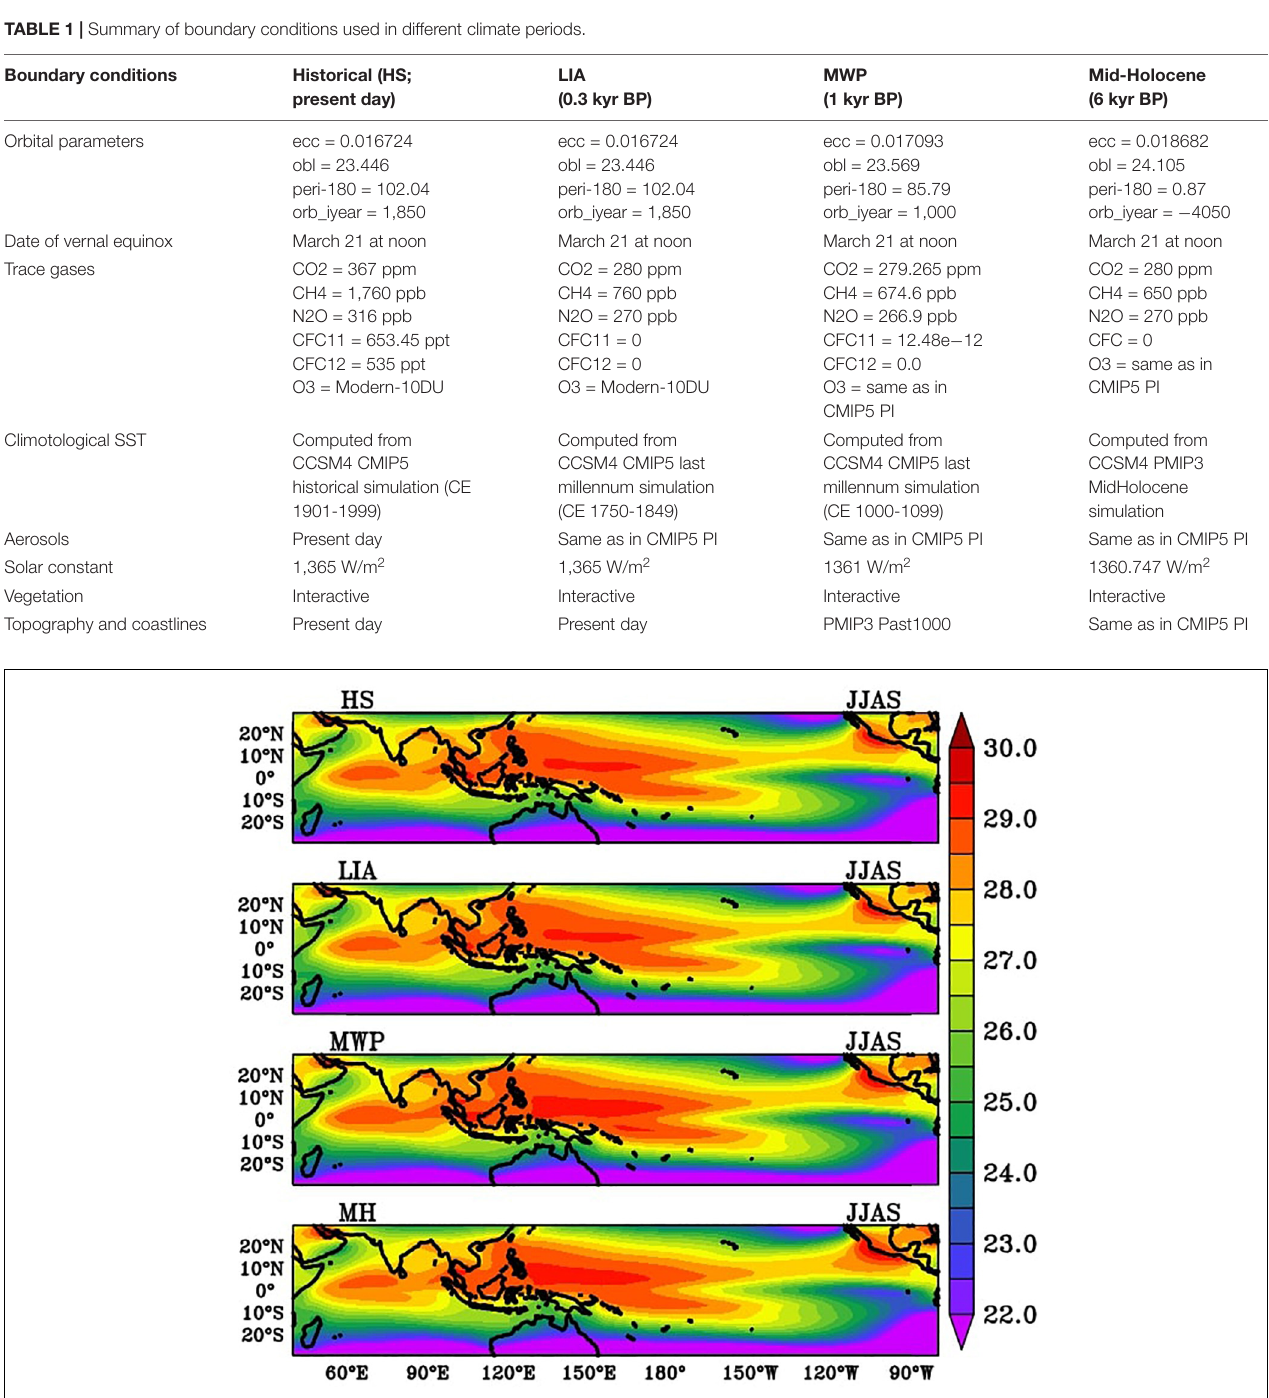
FIGURE 1 | Mean sea surface temperatures ( ◦ C) for the months of June to September used in the control simulations for MH, MWP, LIA, and HS